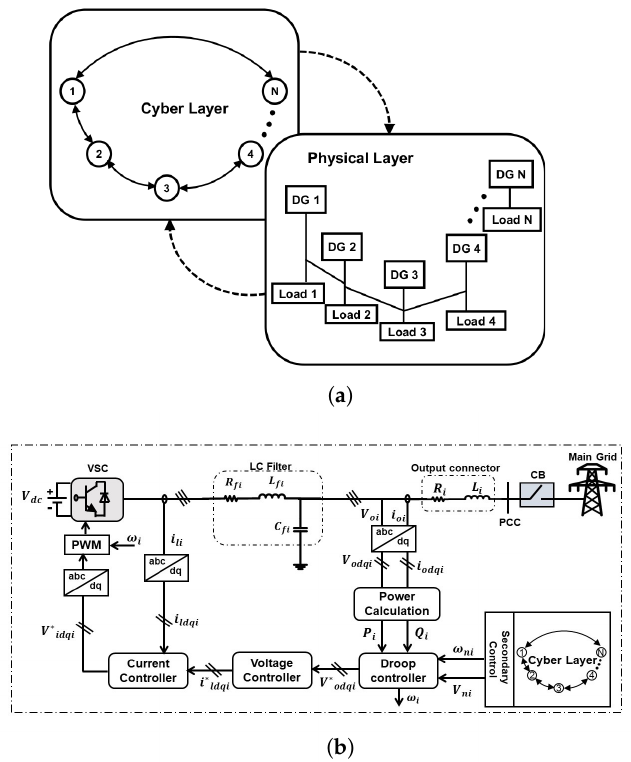
Figure 1. ( a ) Cyber-physical microgrid system. ( b ) Dynamical model of DG